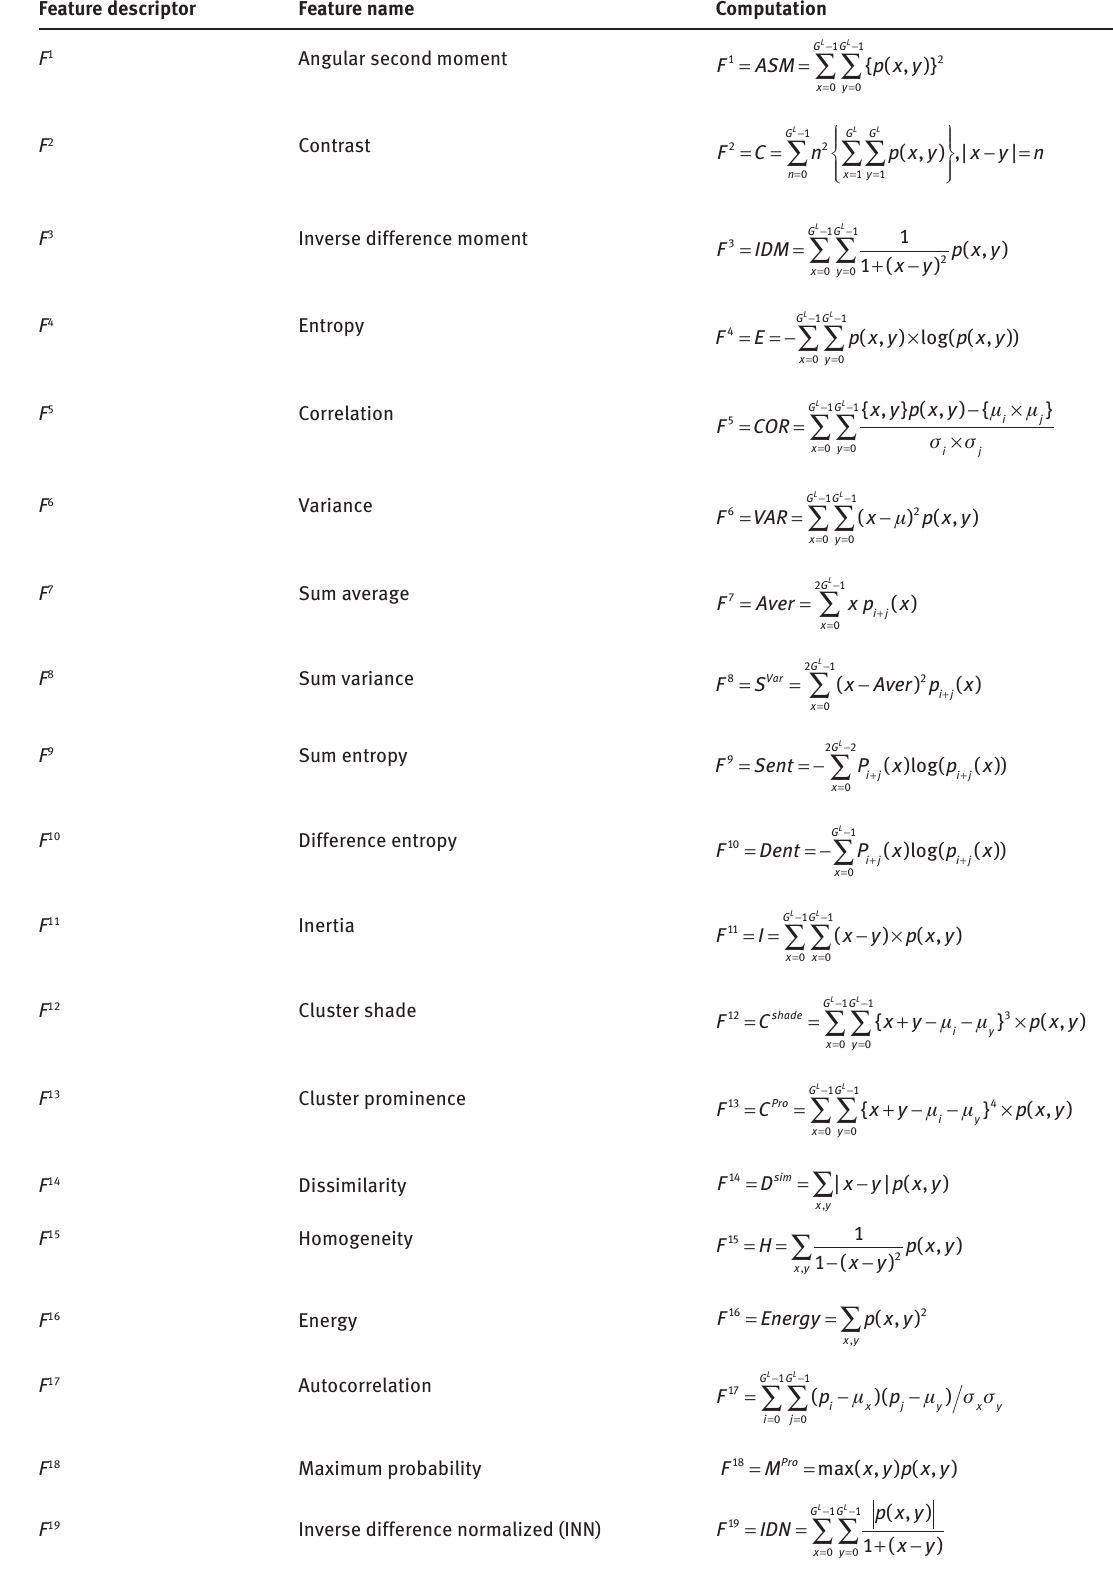
Table 1: GLCM Feature Used in the Proposed Brain Tumor Detection